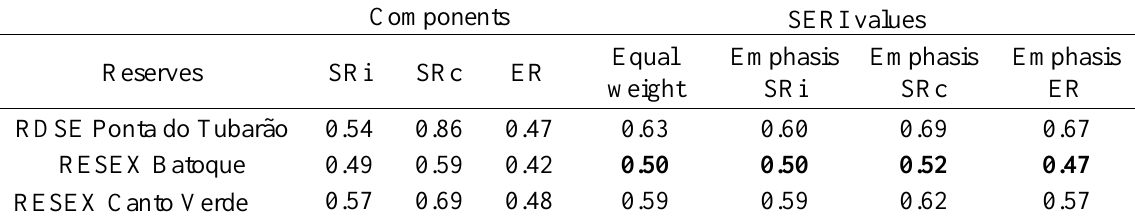
Table A6.1: Components and index values in the weighting scheme: equal weight (same weight among components), Emphasis SRi (SRi component weighing ½ and the other two weighing ¼), Emphasis SRc (SRc component weighing ½ and the other two weighing ¼), and Emphasis ER (ER component weighing ½ and the other two weighing ¼). SRi = Social resilience at individual level; SRc = Social resilience at community level; ER = Ecological resilience; SERI = Index of Social-Ecological Resilience. Highlighting the least resilient reserve in each weighting scheme